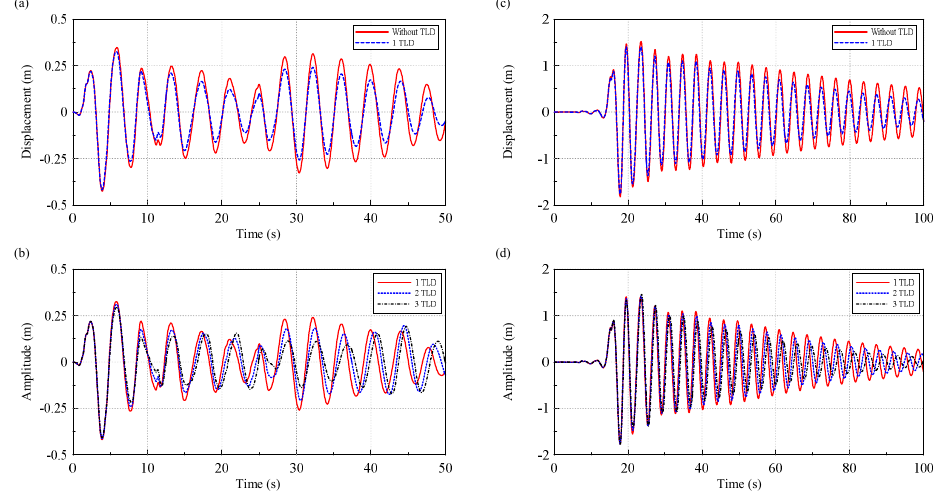
Figure 29. The side-to-side displacement of the OWT with various TLDs: ( a ) and ( b ), El-Centro earthquake; ( c ) and ( d ), Chi-chi earthquake.